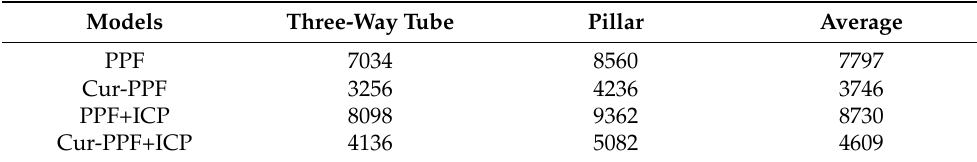
Table 7. Time using of PPF and Cur-PPF algorithms on real data sets (ms/scene).